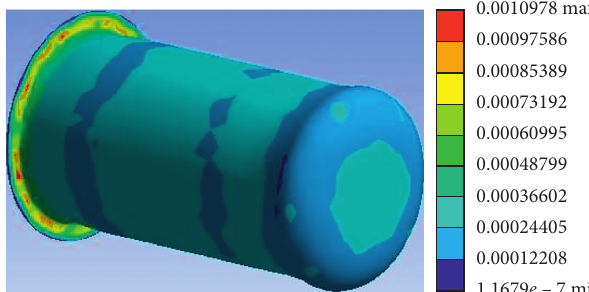
Figure 25: Equivalent strain cloud diagram of the uncoupled flame